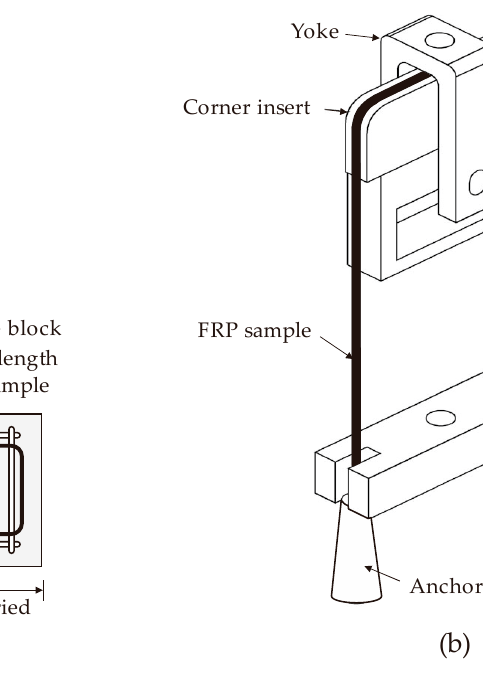
Figure 5. ACI test method: ( a ) B.5 and ( b ) B.12.